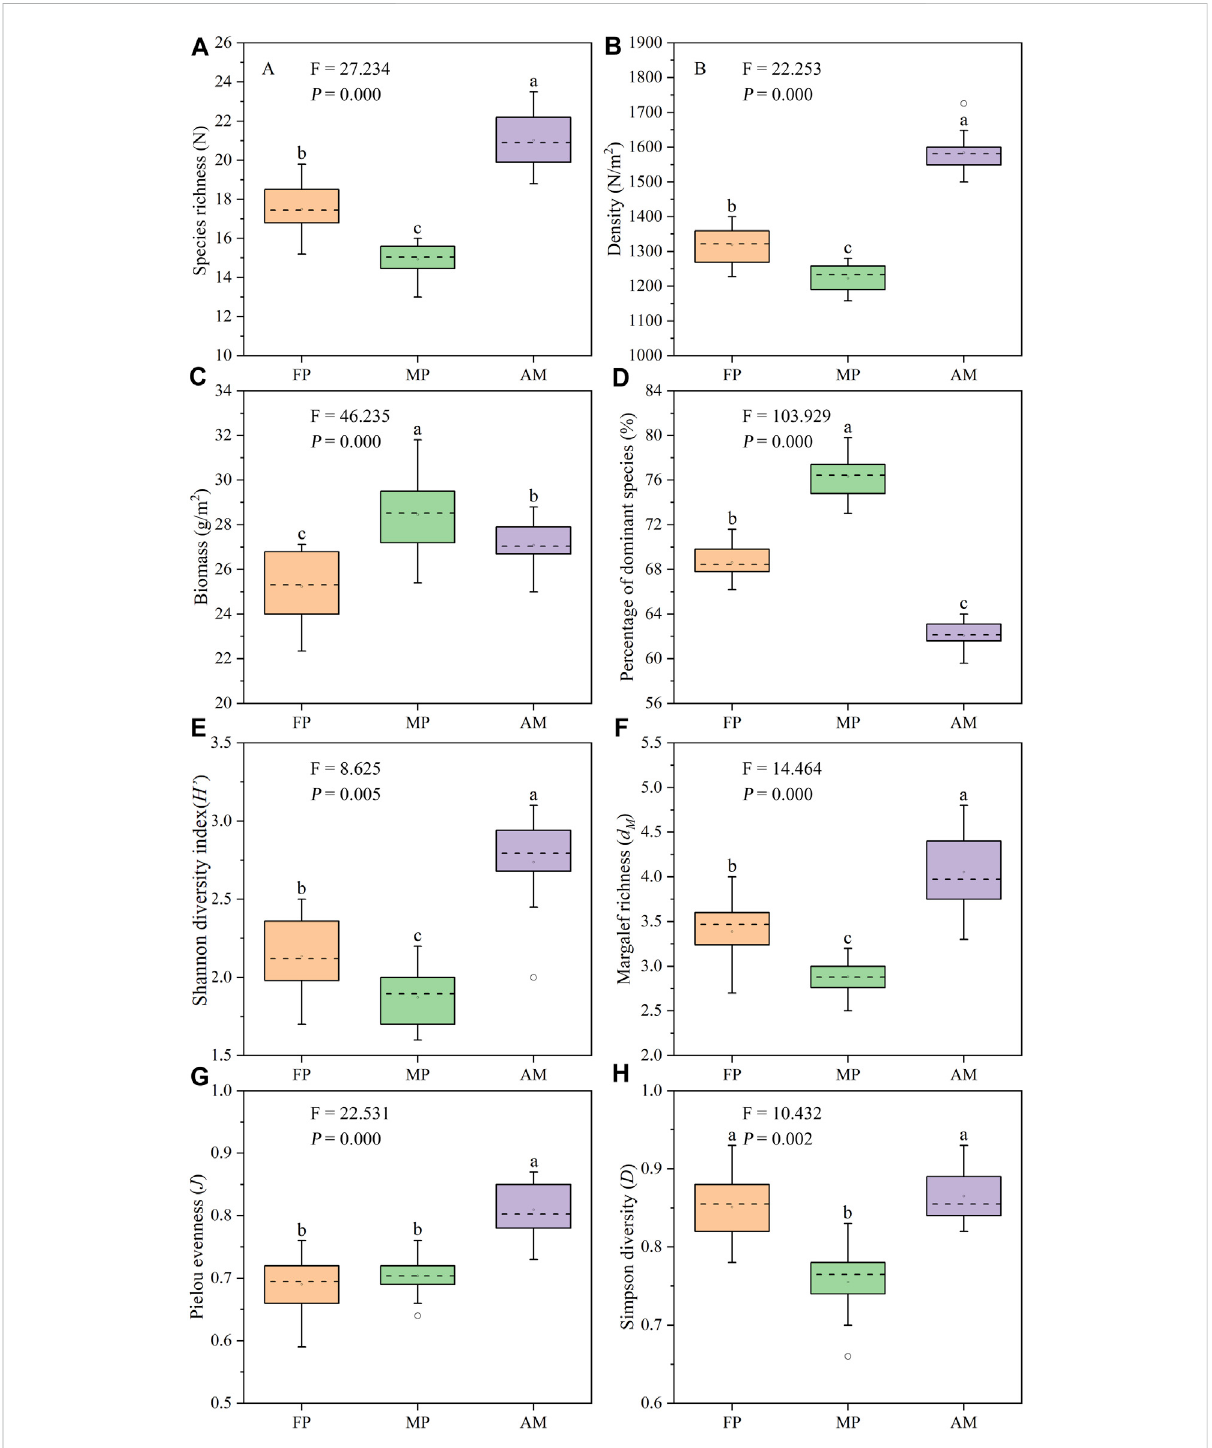
FIGURE 3 Temporal(FP, freezing period;MP, melting period; AM,after themelting period) changesof macroinvertebratespecies richness (A) ,density (B) , biomass (C) , and proportion of dominant species (D) of stream macroinvertebrate species in three periods of snow melting, Shannon diversity index (E) ,Margalefdiversity (F) ,Pielouevenness (G) ,andSimpsondiversity (H) .Boxplotsindicatedinterquartileranges(boxpart),25thand75thpercentiles (lower and upper error bars), and mean values (dash lines in the box). Different lowercase letters indicate signi fi cant differences in invertebrate community structure caused by different